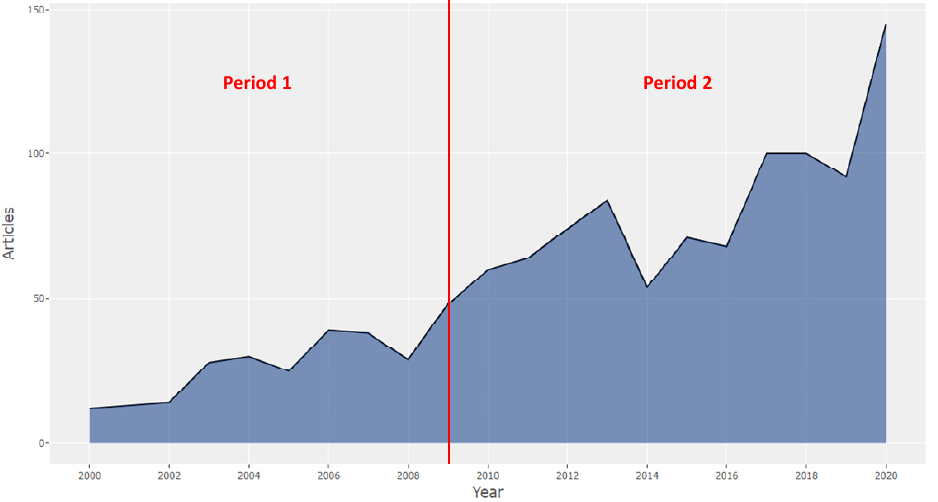
Figure 3. Number of articles related to construction management published during 2000–2020 ( gen- generated by Biobliometrix R ). erated by Biobliometrix R ). (